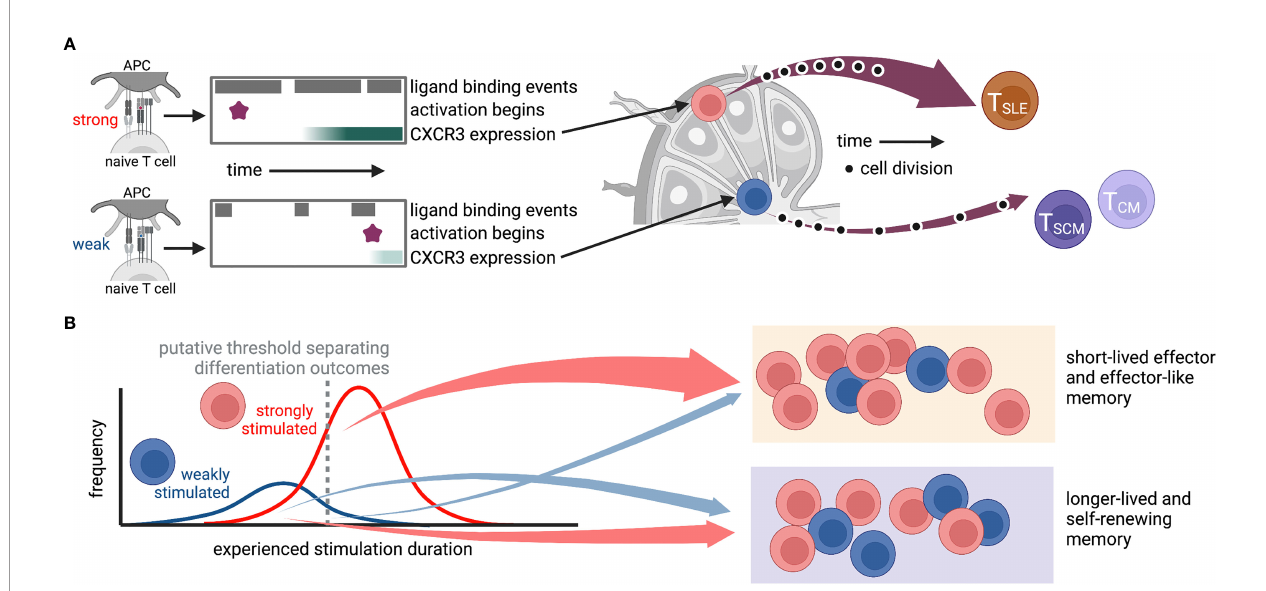
FIGURE 2 | Possible route by which heterogeneity of TCR-ligand interactions could propagate through variations in stimulus duration, gene expression, and localization to diversify the T cell response. In this hypothetical situation, antigen af fi nity affects the frequency and duration of TCR-ligand interactions, the time at which the T cell activates, and expression of genes, including CXCR3. The level of CXCR3 expression then determines whether a cell traf fi cs to the IFR or the middle of the lymph node, where it encounters niche-speci fi c environmental cues that further promote speci fi c differentiation programs. While cartoons in (A) depict a hypothetical “ average ” cell for each stimulus, those in (B) show putative cellular distributions for (left) experienced stimulation duration and (right) differentiation fate. This is only one of many possible routes that may connect ligand binding to differentiation outcomes. T SLE , short-lived effector; T SCM , stem-like memory; T CM , central memory. Created with